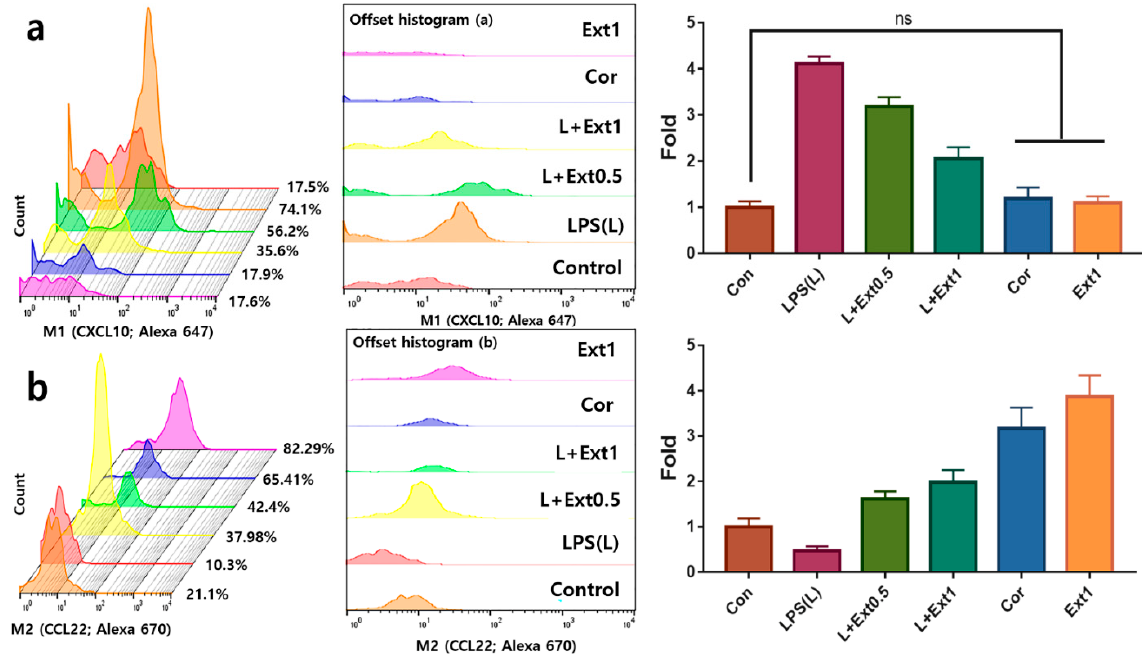
Figure 4. Polarization patterns of macrophages by Cordyceps militaris extracts under LPS stress. Fluorescence in situ hybridization (FISH) results measured by flow cytometry. For the histograms of M1 and M2 labeled cells, populations of macrophages were gated. Changes in M1 and M2 polarization have been shown in panel ( a , b ), respectively. Bar graphs show the relative fold changes for M1 and M2 polarization by the doses of the extract under LPS stress. ns; not significant, LPS; lipopolysaccharide, Ext; extract, Cor; cordycepin. ns; not significant, (all data are p < 0.05 without ns).